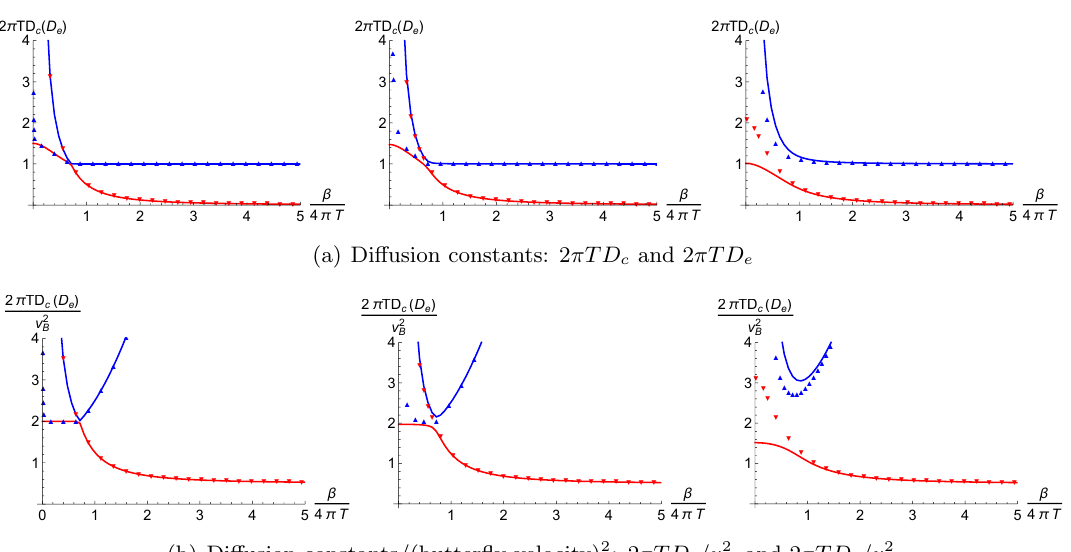
Figure 6 . Di(cid:11)usion constants of the axion-dilaton model with/without a mixing term. (cid:22)=T = 0 : 1 ; 1 ; 5 from left to right. The blue curve is for D c and the red curve is for D e . The triangles display the results without the mixing term M in (3.14). For comparison, we also display the results with the mixing term, the solid curves in (cid:12)gure